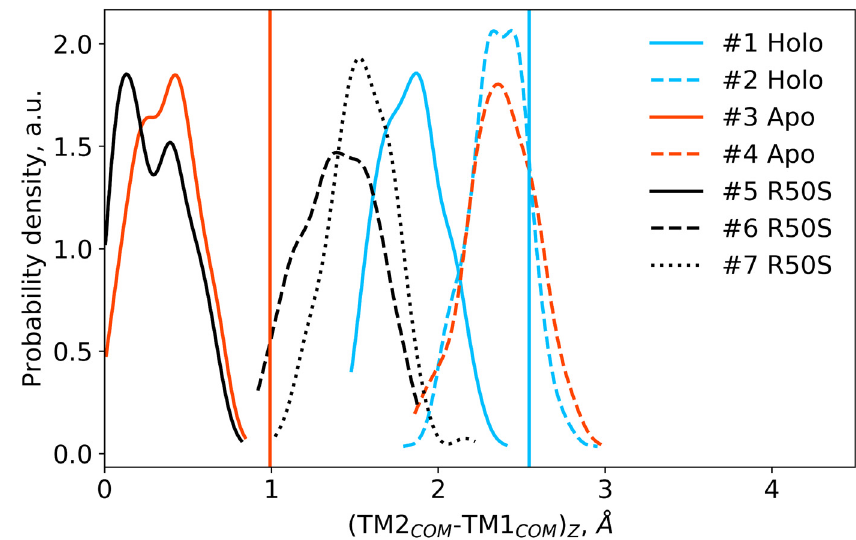
Figure 7. Di ff erence in the projections of the TM1 and TM2 centers of mass on the z axis (normal to the membrane plane) in the last 200 ns of the simulations. Vertical lines show the respective piston shifts in the crystallographic structures: the values for the symmetric ligand-bound WT structure (PDB ID 5IJI) are shown in cyan, the values for the symmetric ligand-free WT structure (PDB ID 5JEQ) are shown in orange.